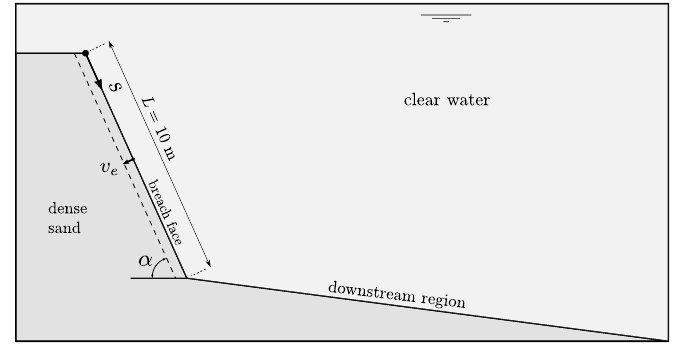
Figure 8. Sketch for the case considered in the numerical runs. v e is the erosion velocity; α is the slope angle.